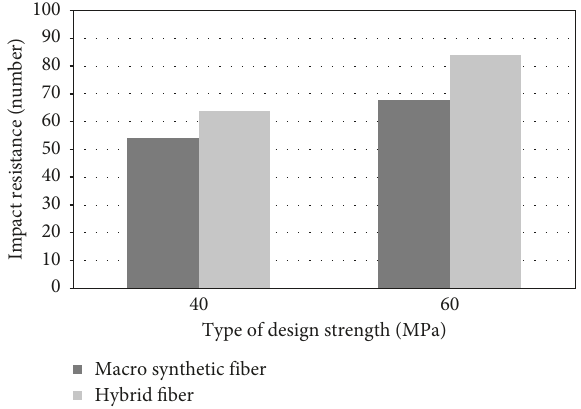
Figure 8: Impact resistance of the optimum